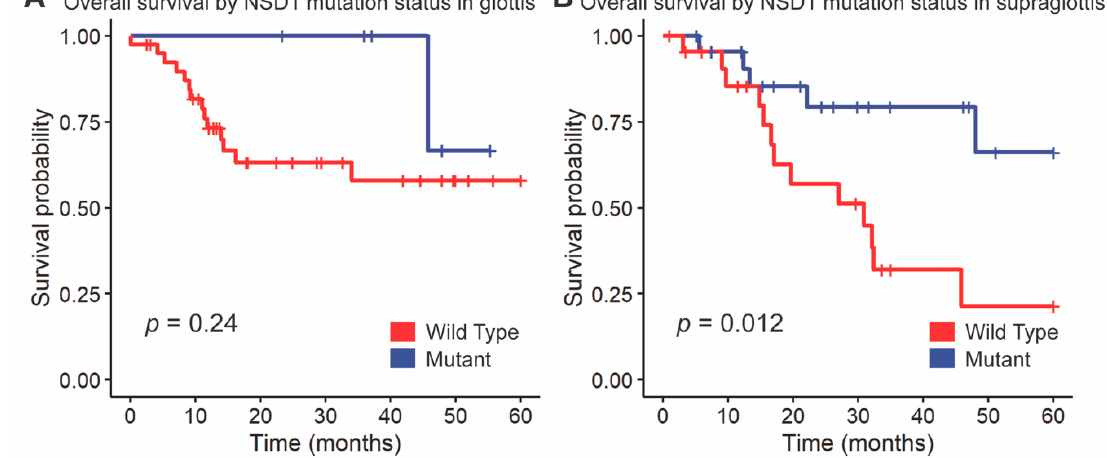
Figure 4. Kaplan-Meier curves for overall survival by NSD1 mutation status, stratified by ( A ) glottis and ( B ) supraglottis. A log-rank test was used to compare the Kaplan-Meier curves between tumors with wild-type and mutant alleles.